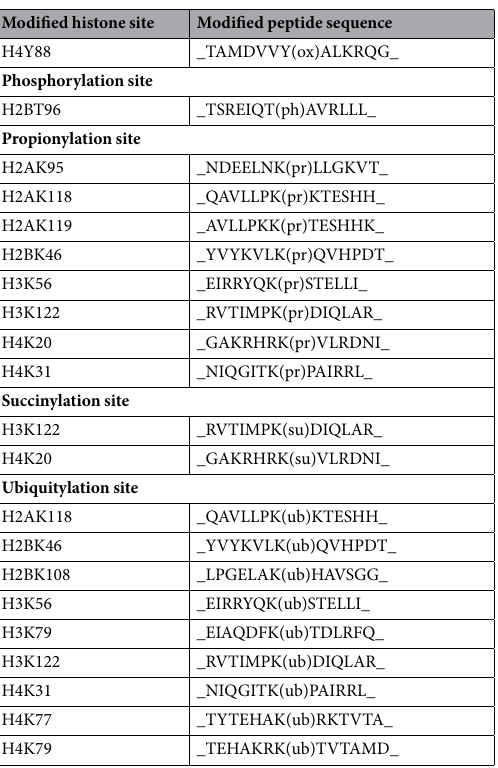
Table 6. Selected post-translational modification sites identified on the core histones and the modified peptide sequences in heat shock protein 90 inhibitor-treated bladder cancer 5637